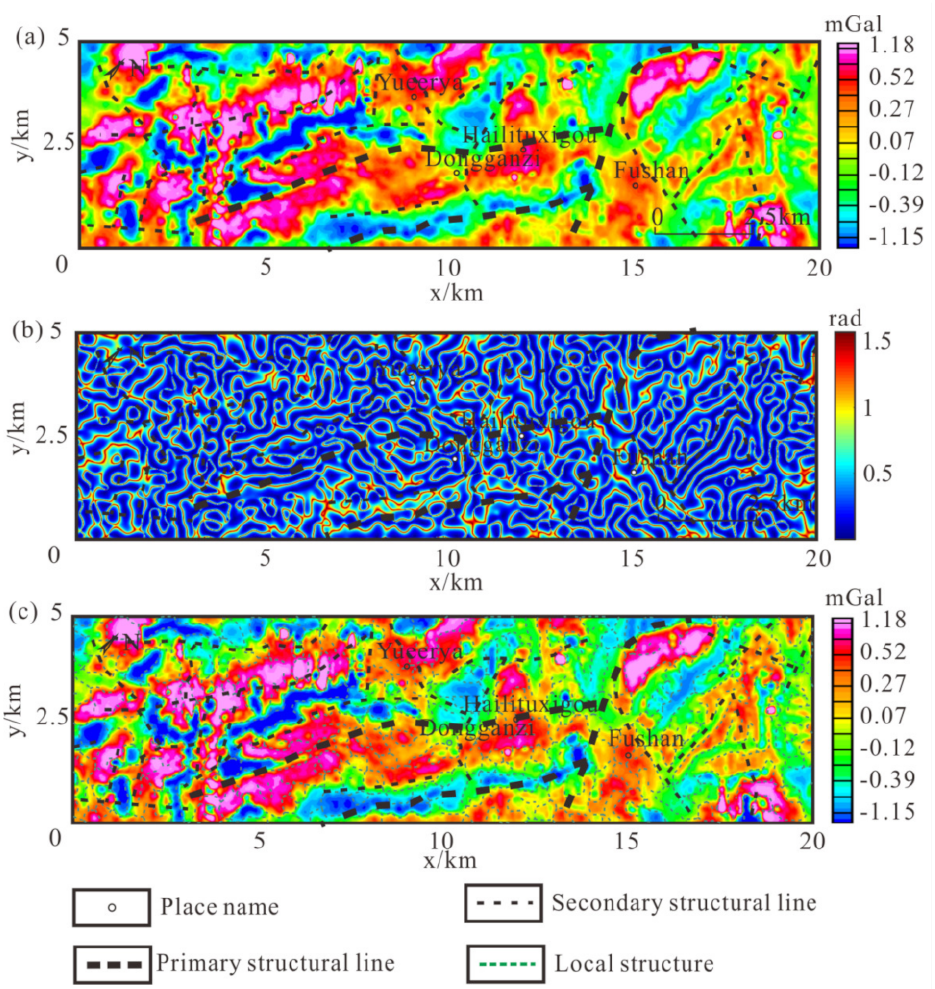
Figure 10. Preliminary division results of local structures in the study area: ( a ) Residual anomaly in the study area; ( b ) SD results of residual anomaly; ( c ) Structure division